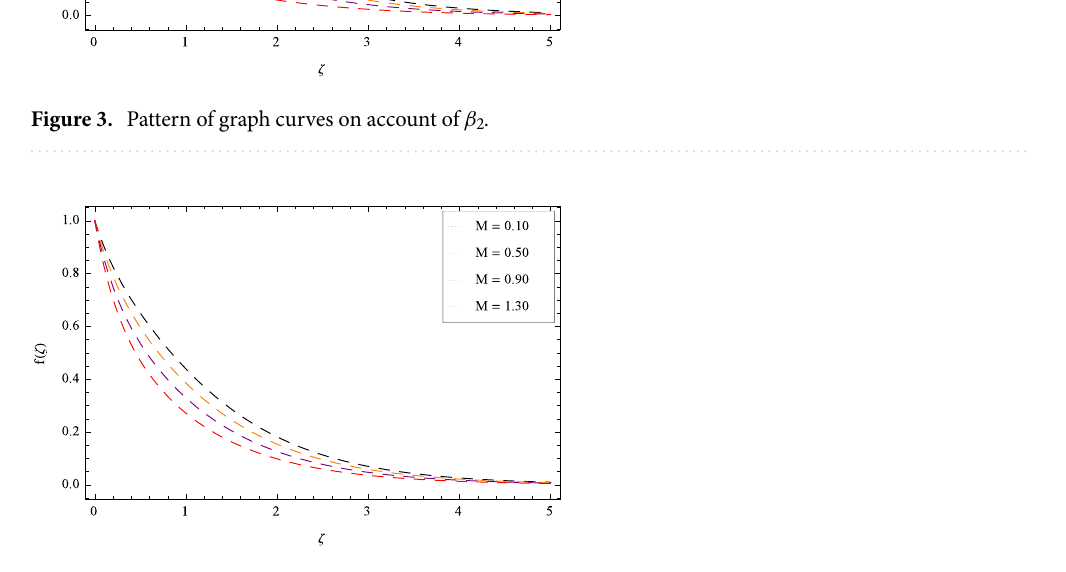
Figure 4. Pattern of graph curves on account of M